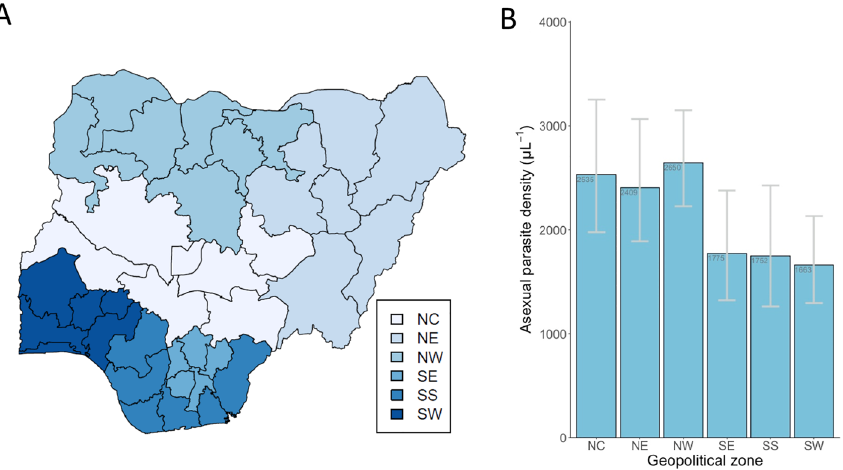
Figure 1. Malaria parasite densities within infections in children up to 5 years of age vary among the major geopolitical regions of Nigeria. ( A ) Map of Nigeria, showing the major six geopolitical zones of the country, and the individual states (map produced in R using the naijR package). ( B ) Geometric mean parasite densities (with 95% confidence intervals) among slide-positive children in the six different major geopolitical zones (NC, North Central; NE, North East, NW, North West; SE, South East; SS, South South; SW, South West). There is significant overall heterogeneity (Kruskal–Wallis test, P < 0.001), and each zone in the north of the country has higher density infections than each zone in the south of the country (Mann–Whitney pairwise tests, P <